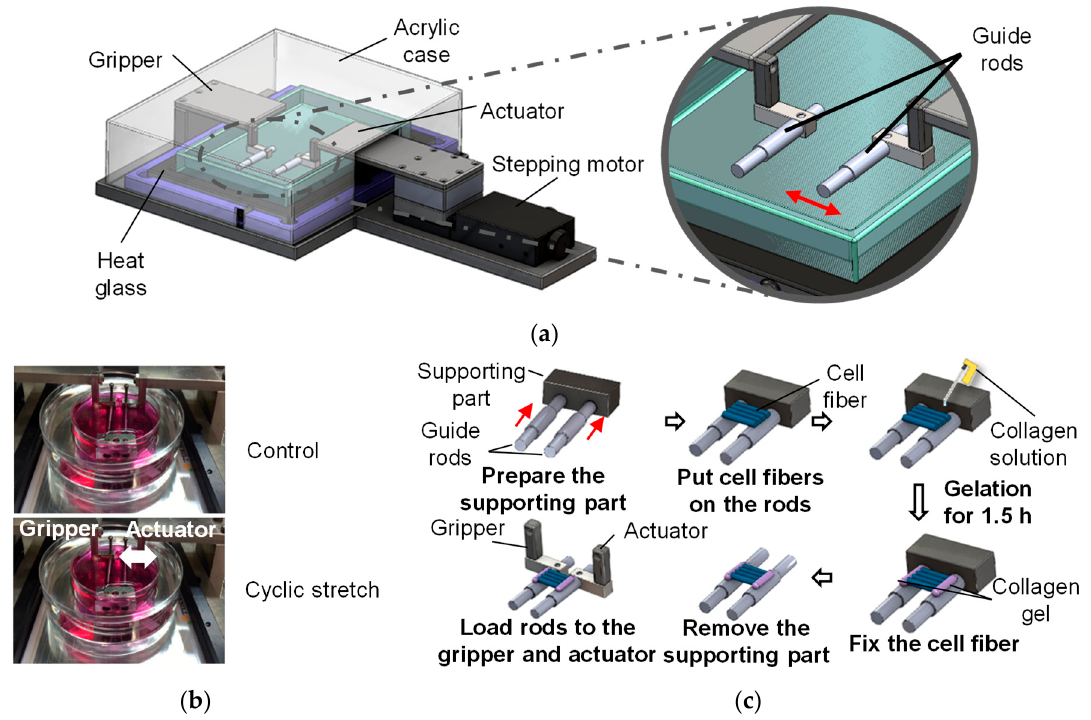
Figure 3. Custom-made cell culture device for “cell fiber” to impose the cyclic stretch. ( a ) Schematic of the culture device, ( b ) photograph of the gripper for hydrogel fibers, and ( c ) procedure to grab the fibers using the collagen gel and two stainless rods.